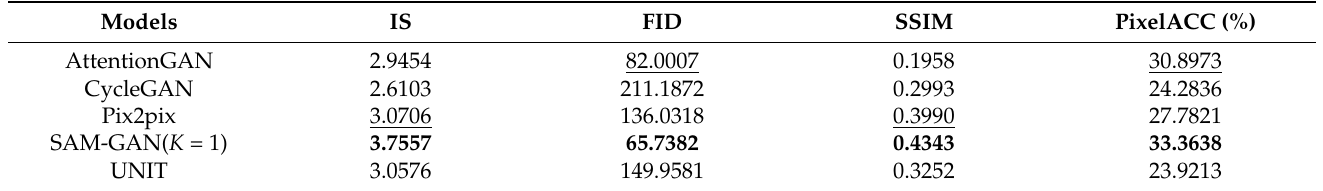
Table 1. Quantitative results of the baseline model and SAM-GAN ( K = 1) on the performance of aerial image-to-map translation for different evaluation metrics, where δ is taken as 5. (Bold: performance first; underlined: performance second).